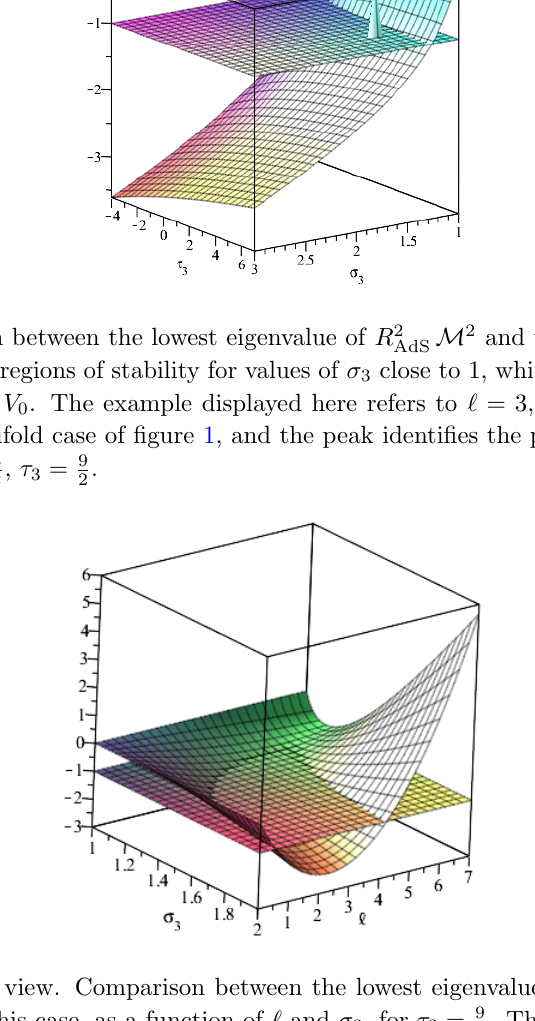
M 2 and the BF AdS . There are regions of stability 2 and to negative R 2 AdS